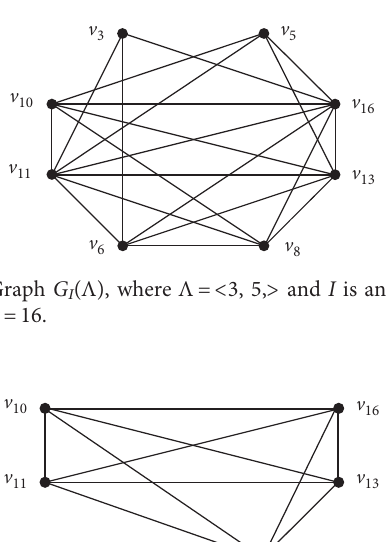
I ( Λ ) given in Figure 5.